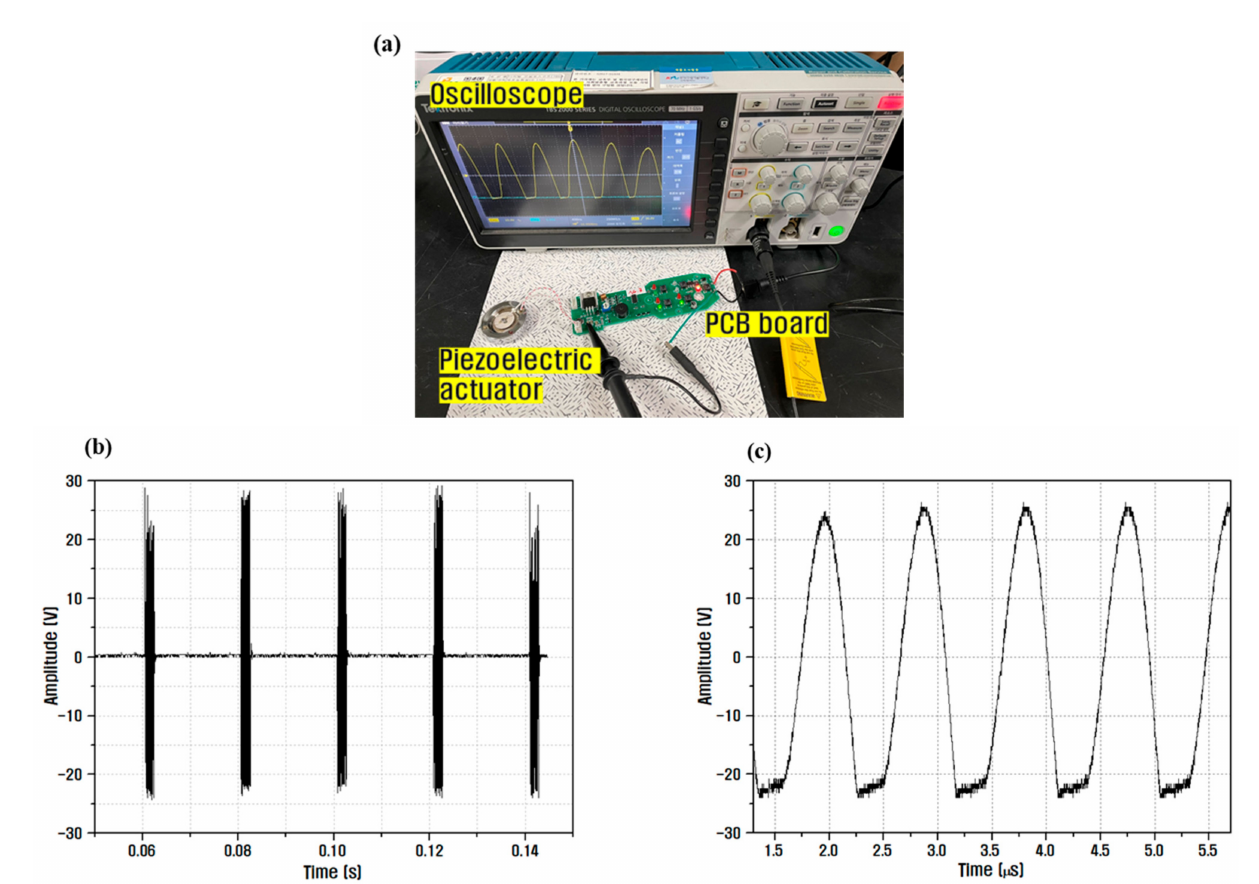
Figure 8. ( a ) Experimental apparatus for performance evaluation of ultrasonic vibrator, analysis results of ( b ) ultrasonic output waveform, and ( c ) detailed